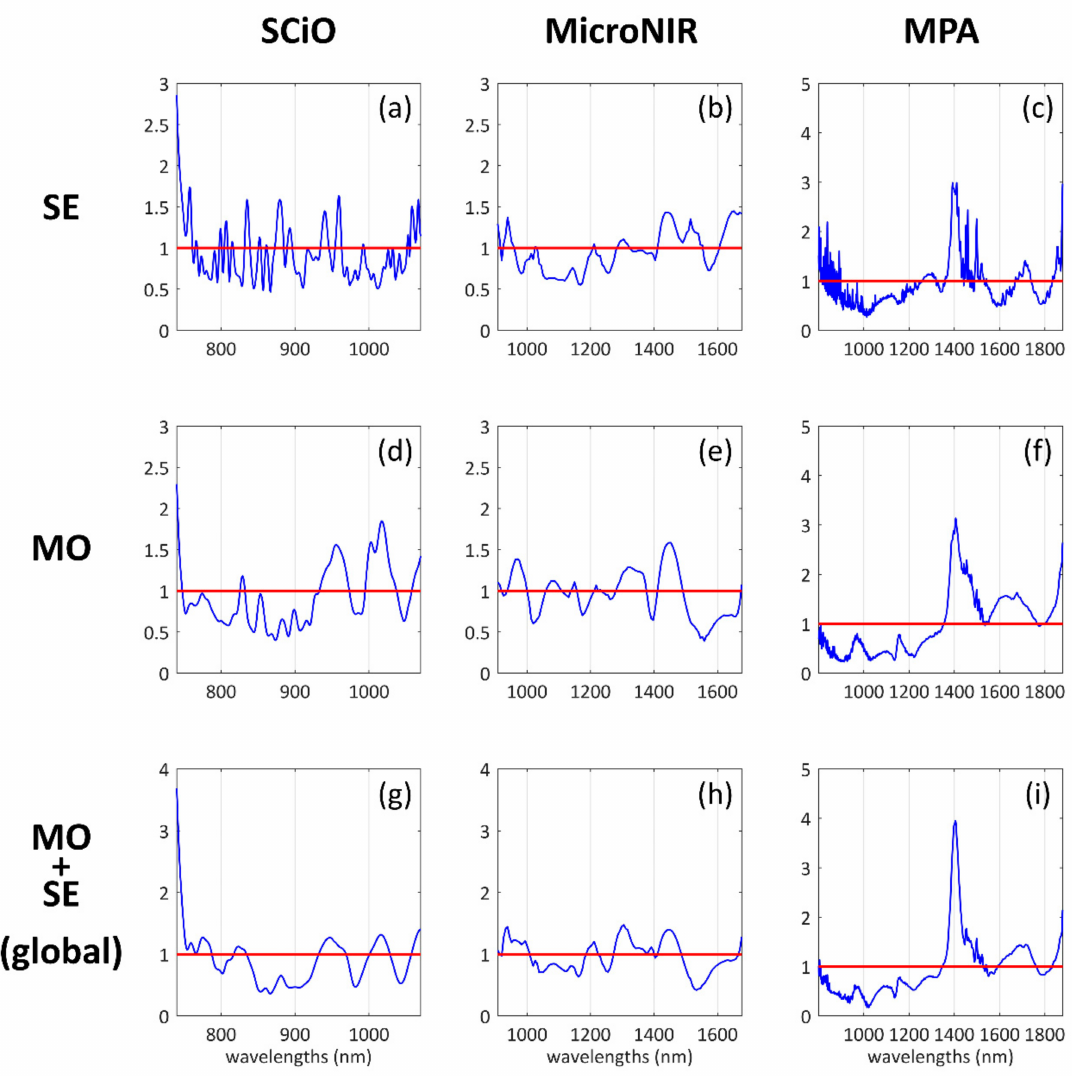
Figure 2. Partial least squares-discriminant analysis (PLS-DA) variable importance in projection (VIP) scores of cuttlefish’ (SE; ( a – c )), musky octopus’ (MO; ( d – f )) and global ( g – i )